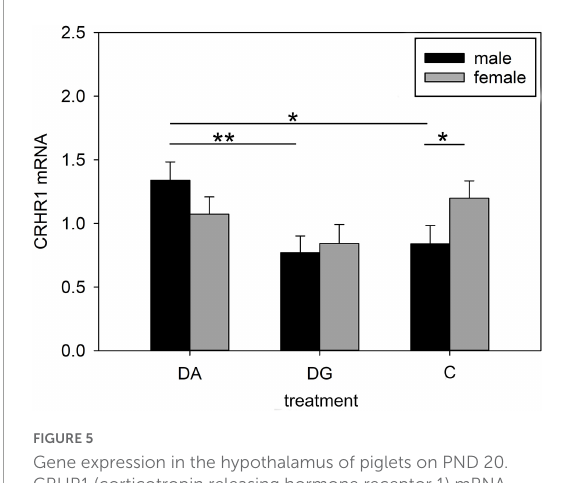
FIGURE5 Gene expression in the hypothalamus of piglets on PND 20. CRHR1 (corticotropin releasing hormone receptor 1) mRNA expression of DA (deprivation alone), DG (deprivation with a group of littermates) and C (control, no deprivation) piglets. Data are expressed as arbitrary units after normalization to ACTB and TBP mRNA expression as endogenous reference genes and represent the LS means ± SE. Significant differences are indicated by asterisks (* p < 0.05; ** p < 0.01; Tukey-Kramer test; n = 10 per treatment group and sex).